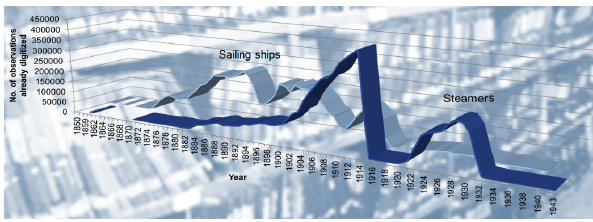
Figure 6. Number of digitized observations from sailing ships and steamers of the German Naval Observatory Hamburg (in total 15.1 million out of approx. 21 million at the time of writing).